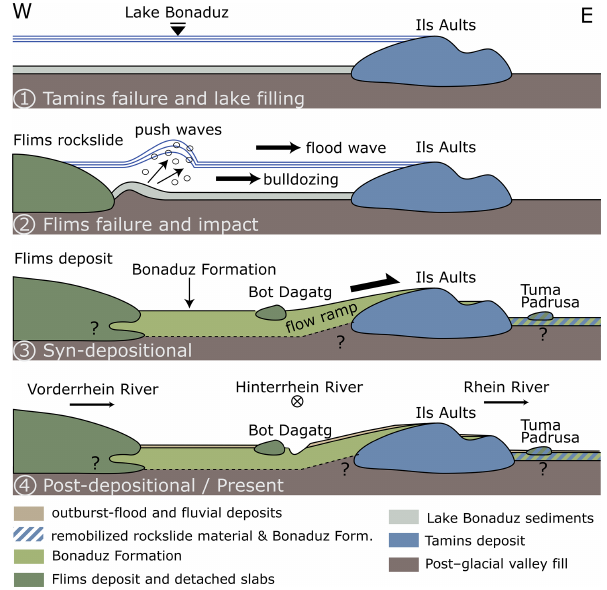
Figure 6. Timeline of geological events displaying the following hypotheses: (Phase 1) Lake Bonaduz dammed by the Ils Aults after Tamins rockslide; (Phase 2) push waves and bulldozing af- ter impact of Flims rockslide; (Phase 3) simultaneous evolution of the Bonaduz Formation, transporting toma; (Phase 4) outburst- flood and recent fluvial deposits partially cover the Bonaduz plain. Schematic sketch without